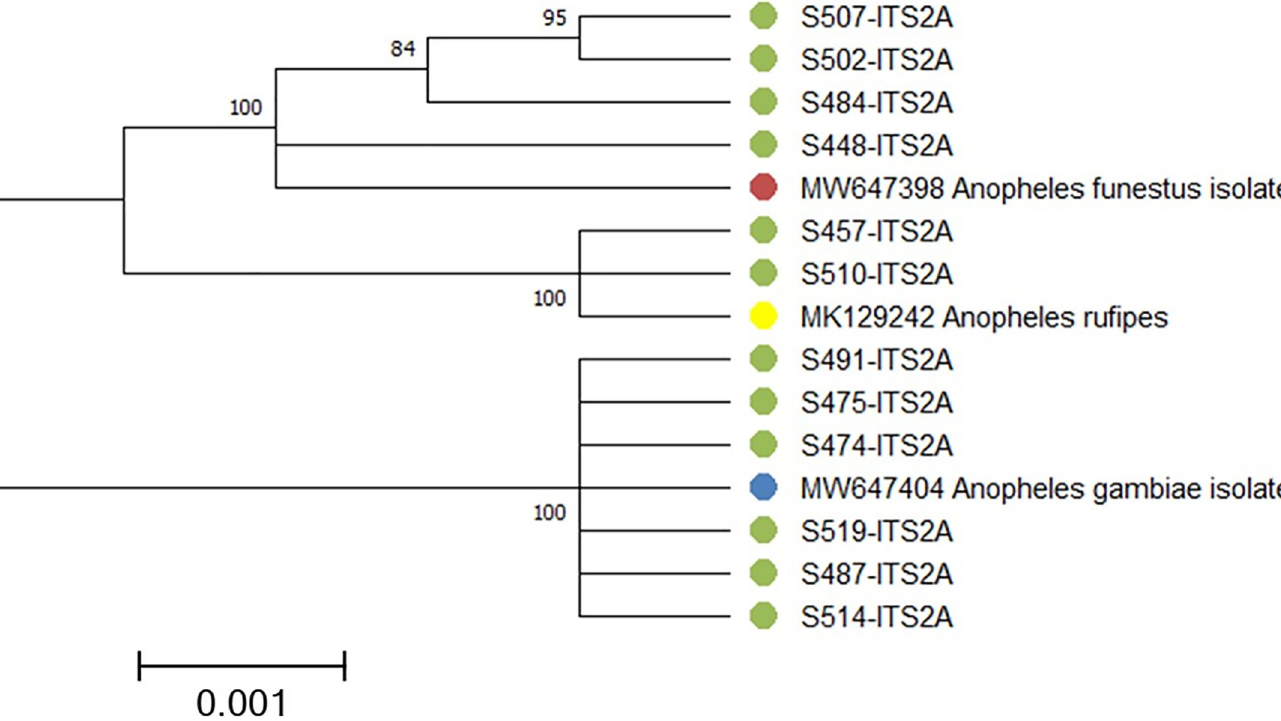
PLOS ONE | https://doi.org/10.1371/journal.pone.0255321 October 11,